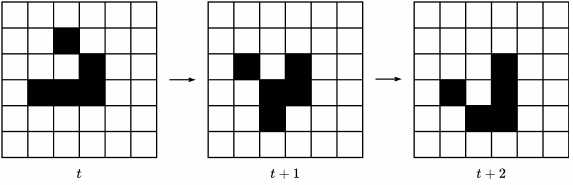
Figure 2. An example of a two-dimensional CA consisting of a grid of 36